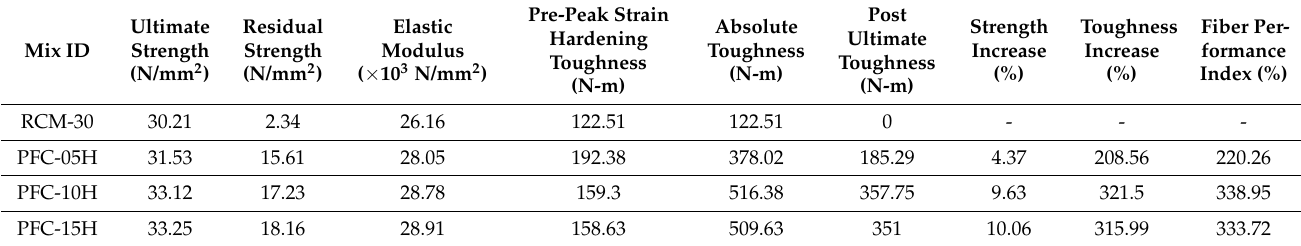
Table 6. Compressive properties of various plastic fiber